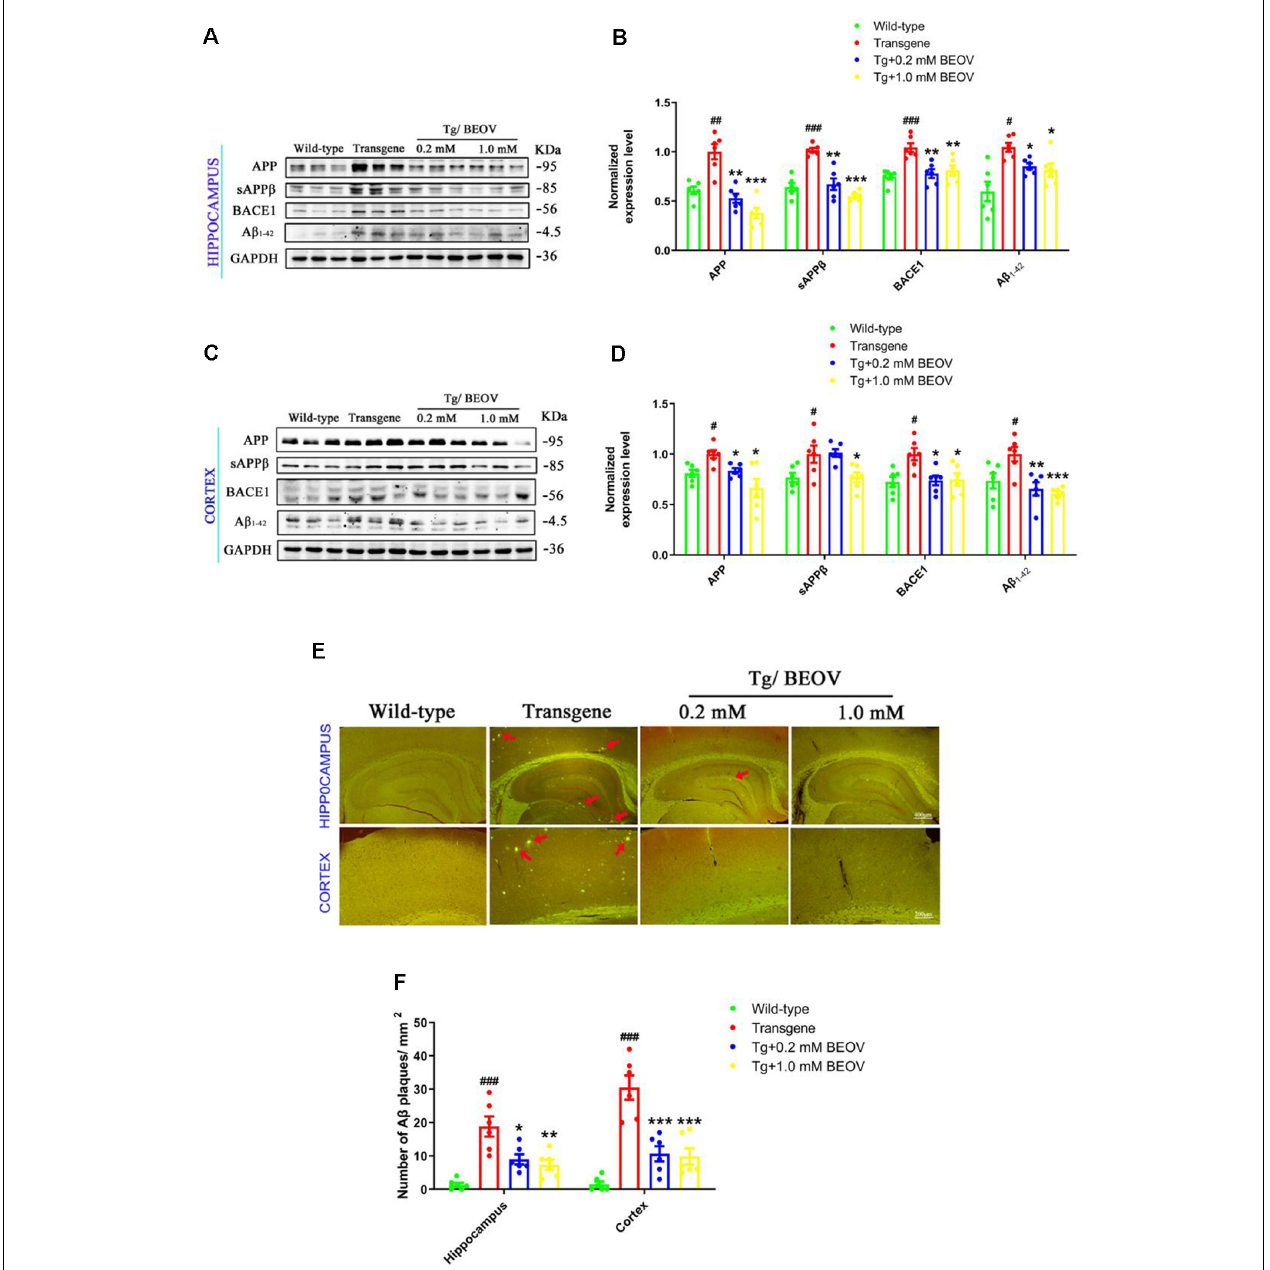
FIGURE 4 | BEOV reduced A β generation in APPSwe/PS1dE9 mice. (A–D) Western blot analyses and semi-quantification of several key proteins involved in amyloidogenic cascade in the hippocampus and cortex of WT, APPSwe/PS1dE9, and BEOV-treated APPSwe/PS1dE9 mice. Quantitative results were normalized against the levels of GAPDH. (E) Thioflavin S staining of A β plaques in the brains of 9-month-old mice. Scale bar: 200 or 400 µ m. (F) Quantification of the number of A β plaques/mm 2 . The plaques were counted in three different fields of view in both hippocampus and cortex, and six sections from different mice in each group were analyzed. # WT group vs. AD group; *AD + BEOV group vs. AD group. n = 6, three females and three males; # P < 0.05, ## P < 0.01, ### P < 0.001, * P < 0.05, ** P < 0.01, and *** P < 0.001, respectively.